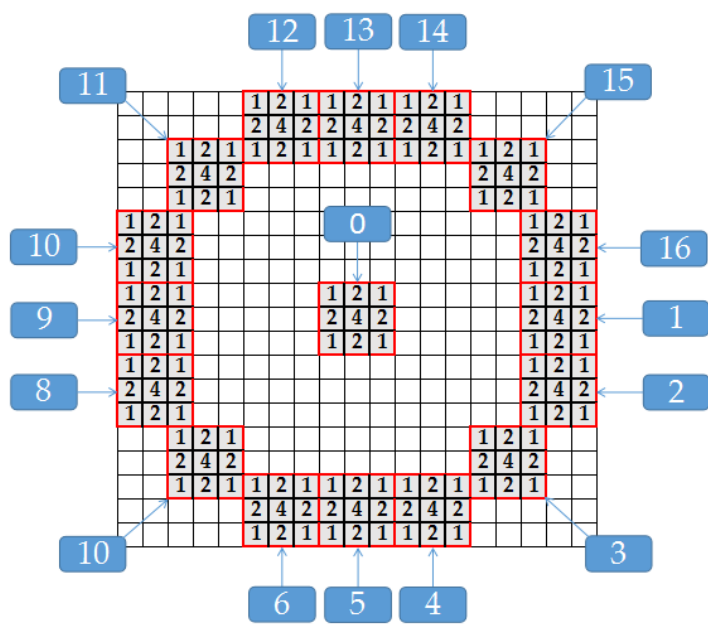
Figure 3. The local processing 19 × 19 window and Gaussian